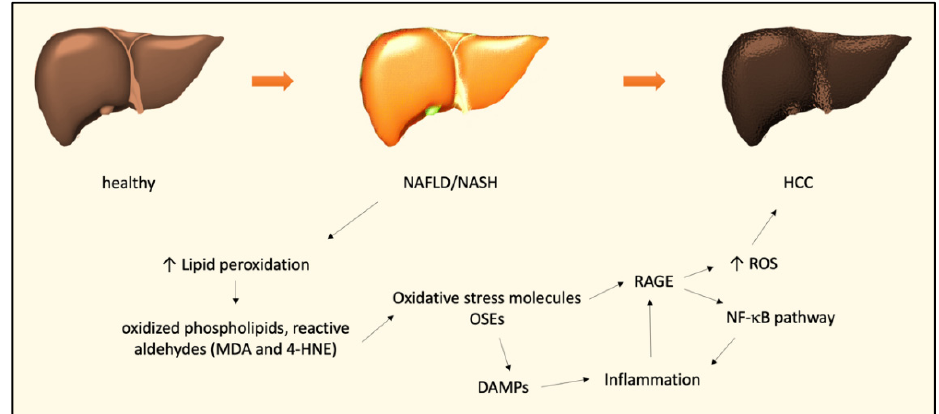
Figure 1. Molecular oxidative stress-related mechanisms involved in the NAFLD–NASH–HCC transition. Abbreviations: non-alcoholic fatty liver disease, NAFLD; non-alcoholic steatohepatitis, NASH; hepatocellular carcinoma, HCC; malondialdehyde, MDA; 4-hydroxynonenal, 4-HNE; oxidation-specific epitopes, OSEs; receptor for advanced glycation end products, RAGE; reactive oxygen species, ROS; damage-associated molecular patterns, DAMPs.